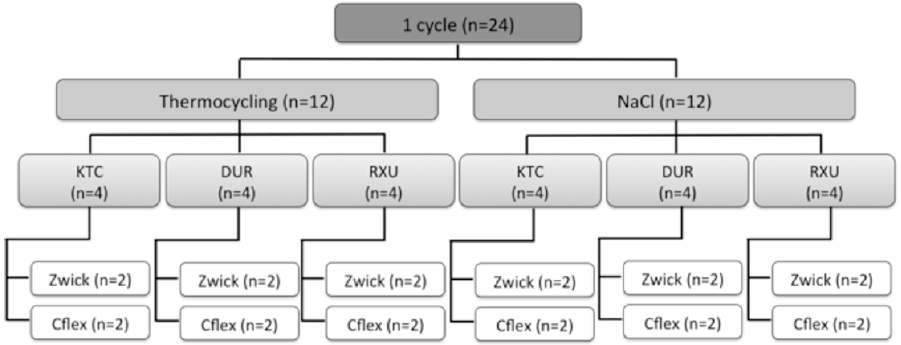
Figure 5. Detailed workflow scheme for one cycle.